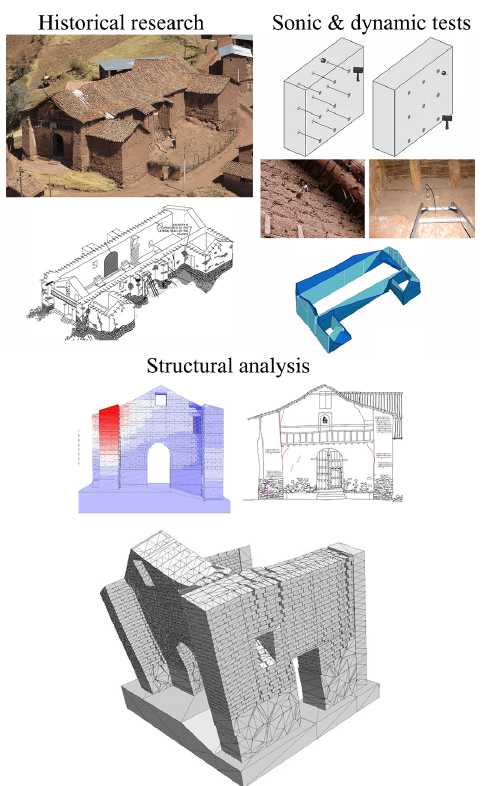
Figure 8. Conservation of cultural heritage buildings, methodology and application to case studies: Church of Kuño Tambo in Peru [16].